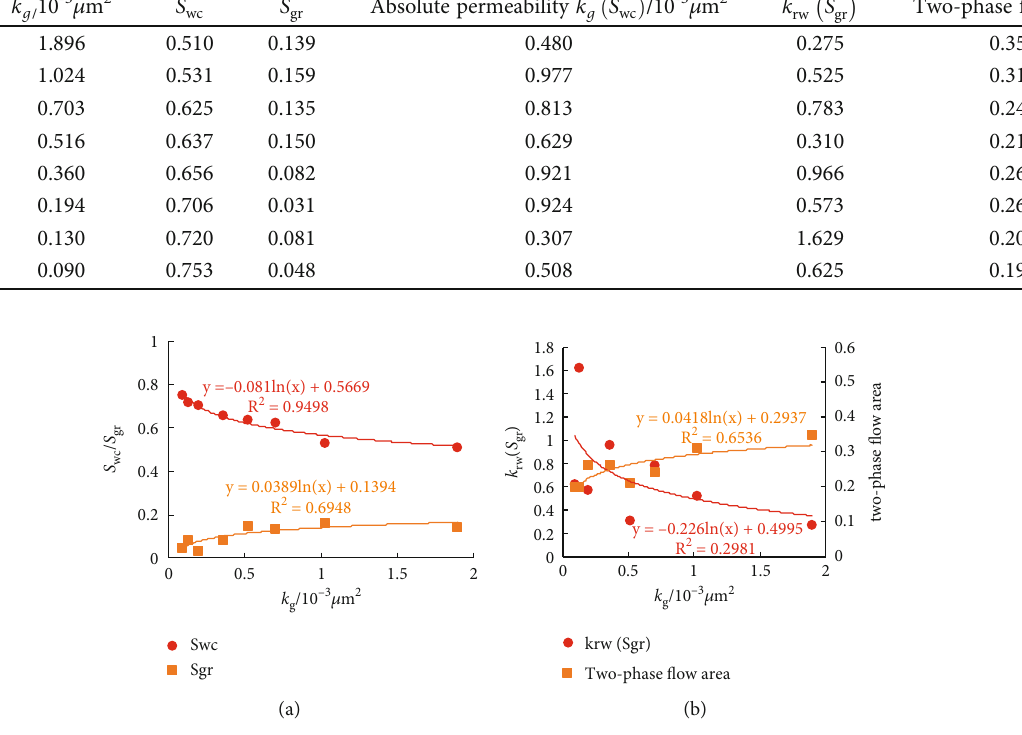
Figure 7: Relationship between characteristic value and permeability of gas – water relative permeability curves: (a) relationship between S / S and k and (b) relationship between k gr g